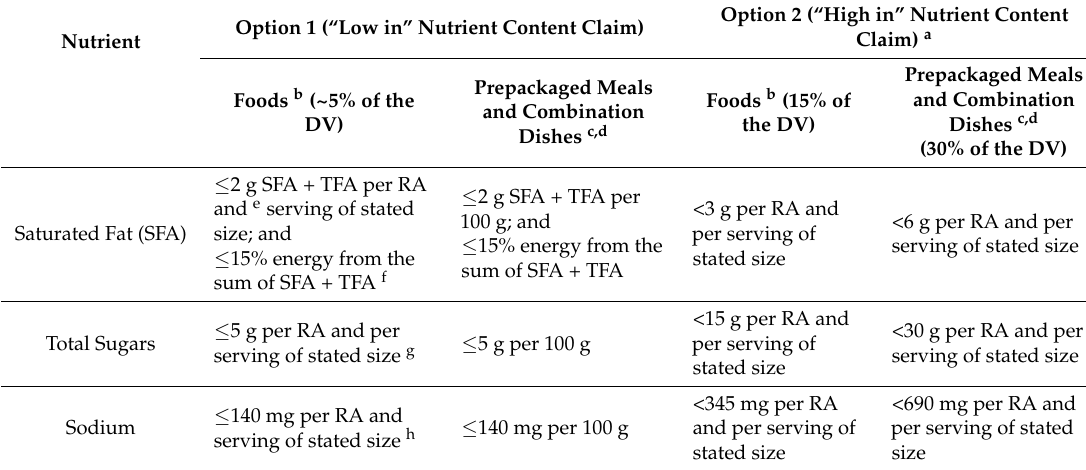
Table 1. Health Canada’s proposed nutrient profile model: Nutrient thresholds considered for restricting marketing to